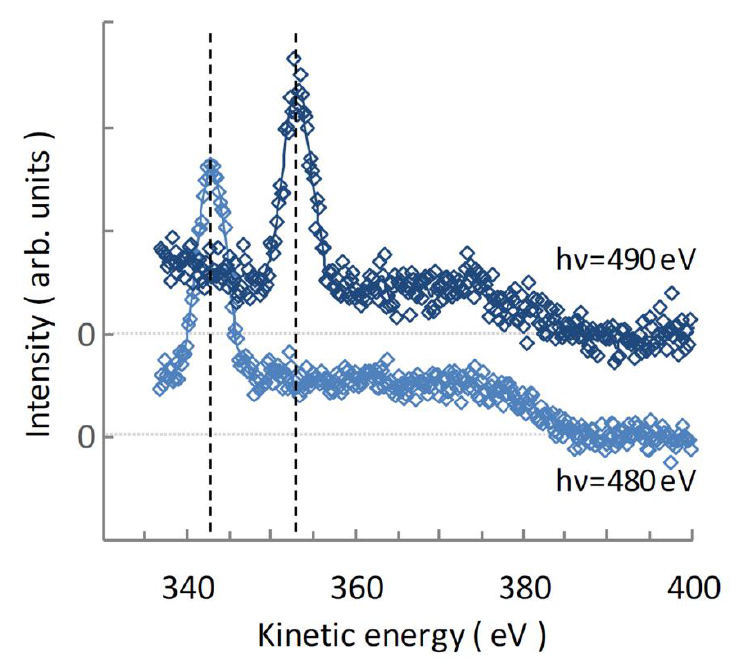
Figure 4. Electron kinetic energy spectra for aqueous UMP at pH = 7.5 at the X-ray photon energies of 480 eV and 490 eV.